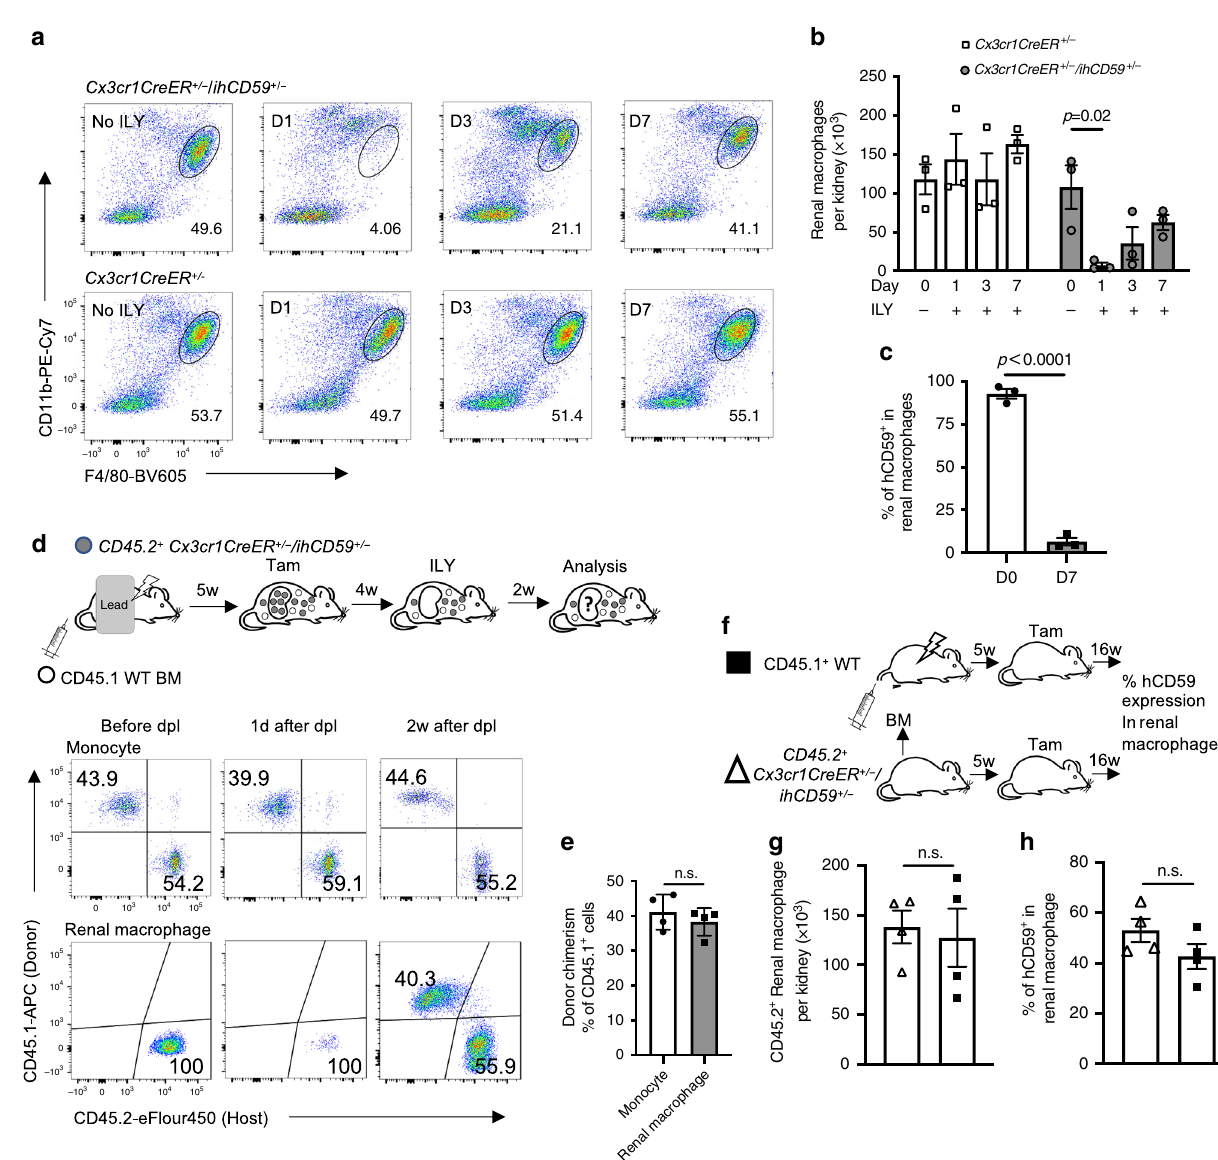
Fig. 4 Peripheral monocytes rapidly differentiate into long-lived RMs after niche is emptied. a Representative fl ow cytometry plots of the percentage of CD11b + F4/80 high (cycled area) RMs among CD45 + leukocytes and b RMs cell counts at different days (D1, D3, and D7) after ILY injection (120 ng/g body weight, i.v.) or without ILY (No ILY). Data are representative of two independent experiments ( n = 3 mice per time point per group). c hCD59 expression on original (D0) and regenerated RMs (D7 after ILY; n = 3 mice per group). d Schematic overview of generation and treatment of chimeric mice by partially irradiating recipient (CD45. 2 + ) male mice followed by reconstitution with the CD45.1 + wild type (WT), bone marrow (BM), and ILY injection. Dot plots show CD45.1 (Donor) and CD45.2 (Host) expression on peripheral monocyte (upper panels) and RMs (lower panels) before, 1 day (d) or 2 weeks (w) after ILY-mediated RMs depletion (dpI). e No signi fi cant difference in donor chimerism (CD45.1/CD45.1 + CD45.2) between monocyte and regenerated RMs at 2 weeks after ILY injection (also shown in the right panel of the dot plots, n = 4 mice per group). f Schematic overview of bone marrow transplantation (BMT) and tamoxifen (Tam) injection. g Cell counts of CD45.2 + RMs in age-matched CD45.2 + Cx3cr1CreER + / − /ihCD59 + / − and chimeric CD45.1 + male mice 5 weeks after BMT ( n = 4 mice per group). h hCD59 expression on original CD45.2 + RMs and regenerated RMs in chimeric mice 16 weeks after tamoxifen ( n = 4 mice per group). All data are presented as mean ± s.e.m. p -values by two-tailed unpaired t -test are indicated in b , c , e , g , h , n.s. indicates p > 0.05. Source data are provided as a Source Data fi covered by a lead shield during the irradiation (upper panel in alveolar macrophages 47 . Only ~5% of newly generated RMs Fig. 4d). This procedure enabled us to develop mice with chimeric expressed hCD59, indicating a minimal contribution of in situ peripheral monocytes and intact recipient CD45.2 + RMs, as proliferation to the repopulation (Fig. 4c). To conclusively determined by the ratio of CD45.1 + vs. CD45.2 + cells. We found demonstrate the origin of RMs after the rapid emptying, we that after 5 weeks of reconstitution, the pools of the peripheral created chimeric mice by partially irradiating Cx3cr1CreER + / − / ihCD59 + / − recipient (CD45.2 + ) mice, which were reconstituted monocytes or RMs were composed of mixed CD45.1 + with CD45.1 + B6 donor BM. To prevent radiation damage of the and CD45.2 + cells (43.9% and 54.2%) or intact CD45. 2 cells CD45.2 + RMs, the abdomen of Cx3cr1CreER + / − /ihCD59 + / − was (100% CD45.2), respectively (left panel of the dot plots in